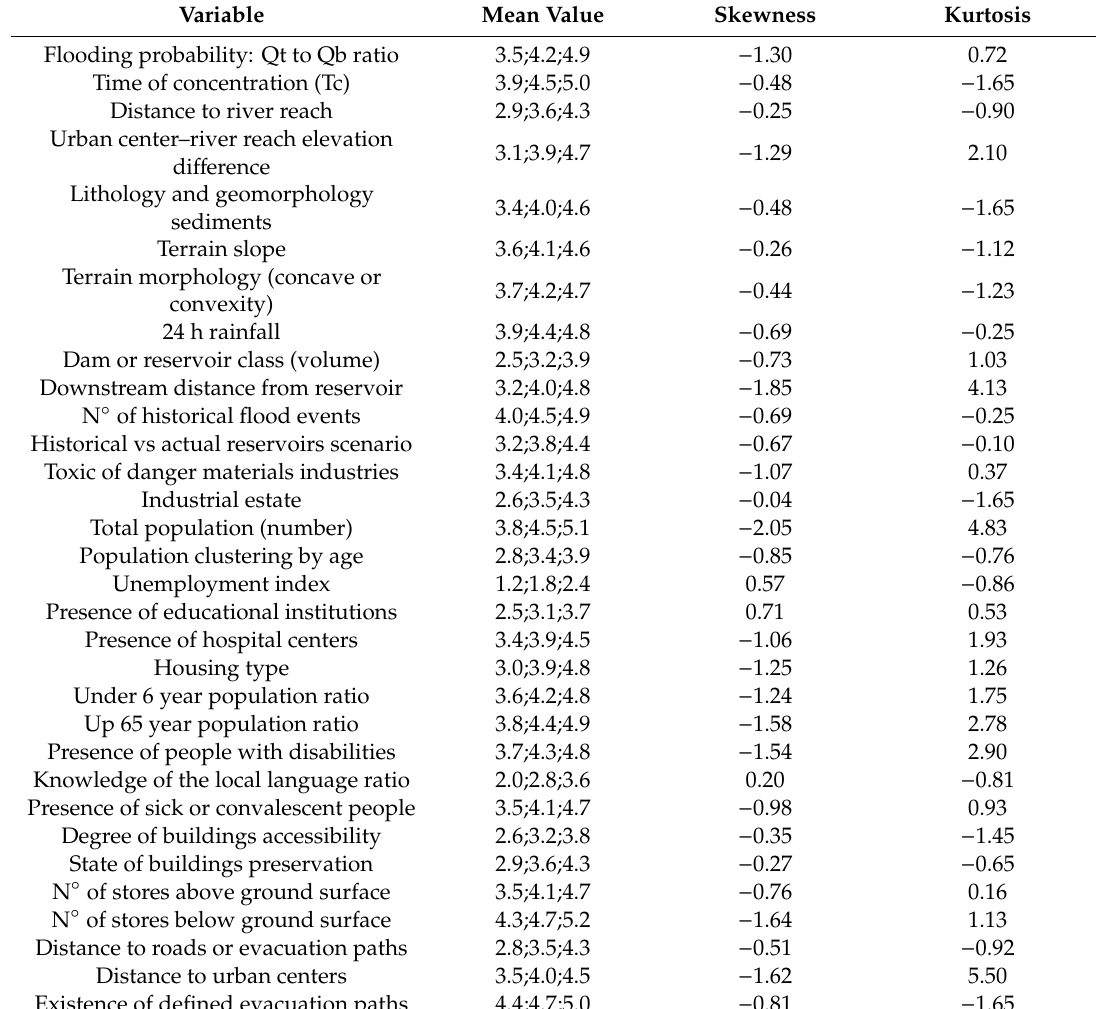
Table 1. List of variables used in PRICAM project and associated values of DELPHI